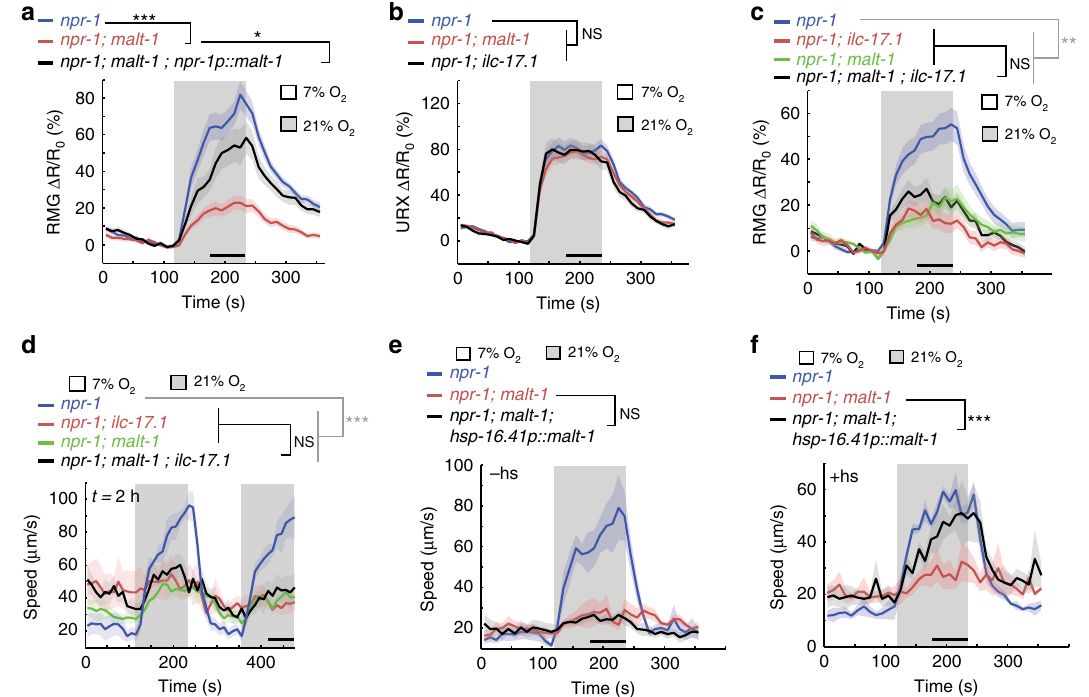
Fig. 4 MALT-1 mediates IL-17 signaling. a and b Disrupting malt-1 attenuates Ca 2 + responses evoked by 21% O 2 in RMG ( a ) but not URX ( b ) neurons. The RMG defect can be rescued by expressing malt-1 cDNA in both RMG and URX, using the npr-1 promoter ( a ). a n = 25 animals ( npr-1 ), n = 35 animals ( npr-1; malt-1 ), n = 24 animals ( npr-1; malt-1; npr-1p::malt-1 ). b n = 20 animals ( npr-1 ), n = 21 animals ( npr-1; malt-1 ), n = 13 animals ( npr-1; ilc-17.1 ). Ca 2 + responses are reported by YC2.60 cameleon. Lines indicate average speed and shaded regions indicate SEM. n = 20 animals ( npr-1 ), n = 21 animals ( npr-1; malt-1 ), n = 13 animals ( npr-1; ilc-17.1 ). * P = 0.03, *** P = 0.0003, two-sided Mann-Whitney U test. c and d Null mutations in malt-1 and ilc-17.1 do not show additive phenotypes when either RMG Ca 2 + transients ( c ) or speed responses evoked by 21% O 2 are measured ( d ). Lines indicate average speed and shaded regions indicate SEM. c n = 29 animals ( npr-1 ), n = 25 animals ( npr-1; malt-1 ), n = 28 animals ( npr-1; ilc-17.1 ), n = 31 animals ( npr-1; malt-1; ilc-17.1 ). d n = 50 animals ( npr-1 ), n = 61 animals ( npr-1; malt-1 ), n = 67 animals ( npr-1; ilc-17.1 ), n = 52 animals ( npr-1; malt-1; ilc-17.1 ). ** P < 0.01, *** P < 0.001, two-sided Mann-Whitney U test. e A transgene expressing malt-1 cDNA from the hsp-16.41 promoter does not rescue malt-1 phenotypes in the absence of heat-shock. Plots show average speed (line) and SEM (shaded regions). n = 35 animals ( npr-1 ), n = 59 animals ( npr-1; malt-1 ), n = 47 animals ( npr-1; malt-1; hsp-16.41p:: malt-1 ). P = 0.14, two-sided Mann-Whitney U test. f Heat-shock-induced cDNA expression in adults restores O 2 – evoked responses to malt-1 mutants. Plots show average speed (line) and SEM (shaded regions); n = 36 animals ( npr-1 ), n = 48 animals ( npr-1; malt-1 ), n = 33 animals ( npr-1; malt-1; hsp-16.41p::malt- 1 ). Plots show average speed (line) and SEM (shaded regions). *** P = 8.77e − 06, two-sided Mann-Whitney U